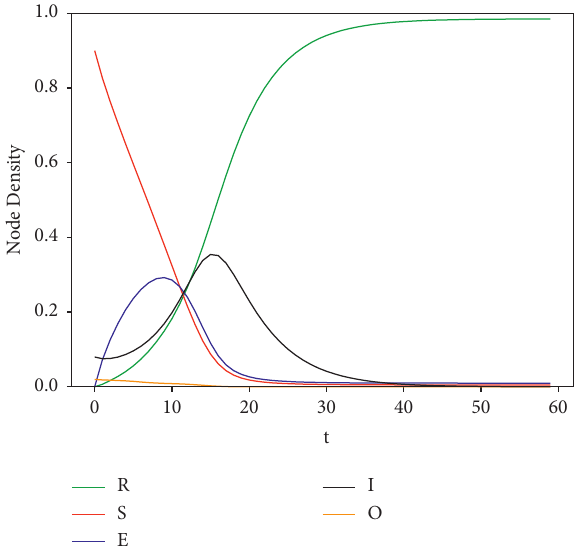
Figure 6: System evolution trend when incomes are always less than risks.